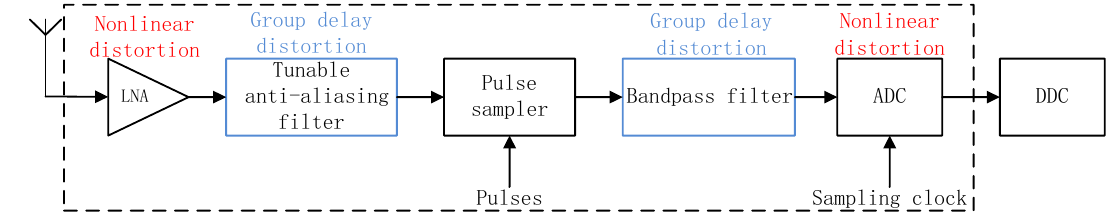
Figure 1. Broadband reconfigurable direct RF front-end.